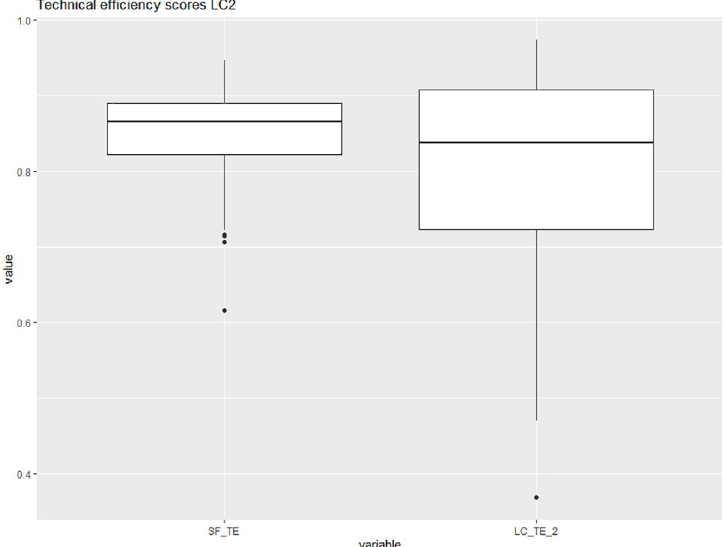
Fig 5. Distributions of the technical efficiency scores for the stochastic frontier (left) and the latent class model based only on the observations belonging to latent class two. Source: Own illustration. https://doi.org/10.1371/journal.pone.0247437.g005 Figs 6 and 7 display the distributions of the technical efficiency scores for the pooled and the latent class model based only on the observations belonging to one of the two sub-disci- plines of life sciences. The classification by the latent class model raises the median estimated technical efficiency for both the agricultural sciences and the biology subsamples. The latent class model indicates that the biology subsample has a larger number of downward outliers. The mean and median technical efficiency score for the biology subsample are both approxi- mately 0.93. Their magnitude is comparable to the mean and median technical efficiency score